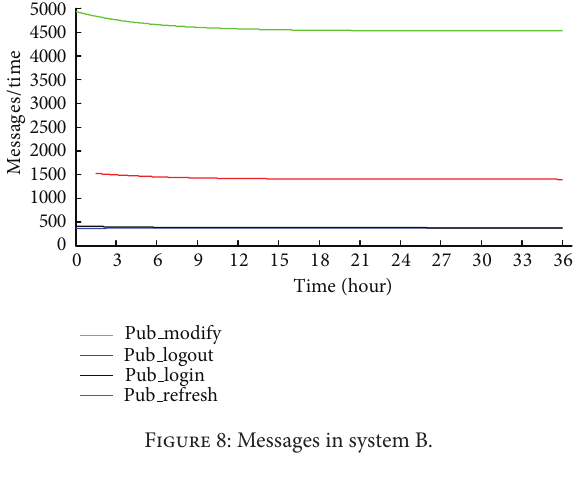
Figure 10: System A with Notify